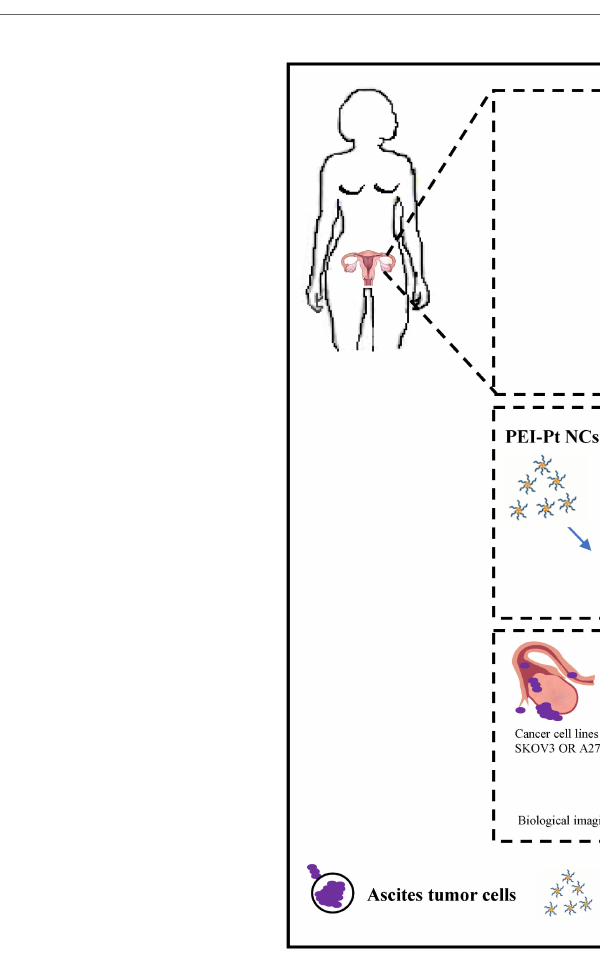
FIGURE 1 | Schematic representation of the process of bioimaging and pro-apoptosis of ovarian cancer cells using fl uorescent PEI-coated Pt NCs as fl uorescent markers and anti-cancer